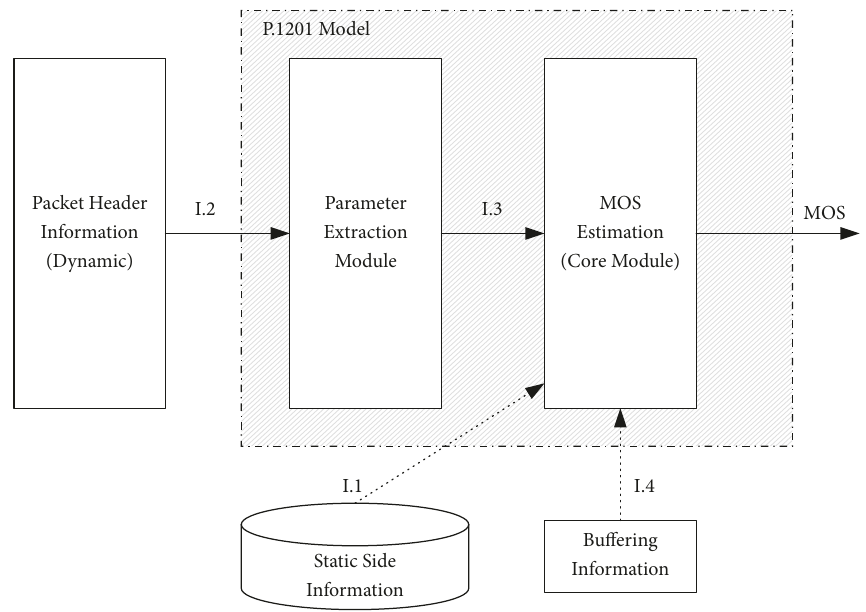
Figure 19: Overview of model inputs and output.